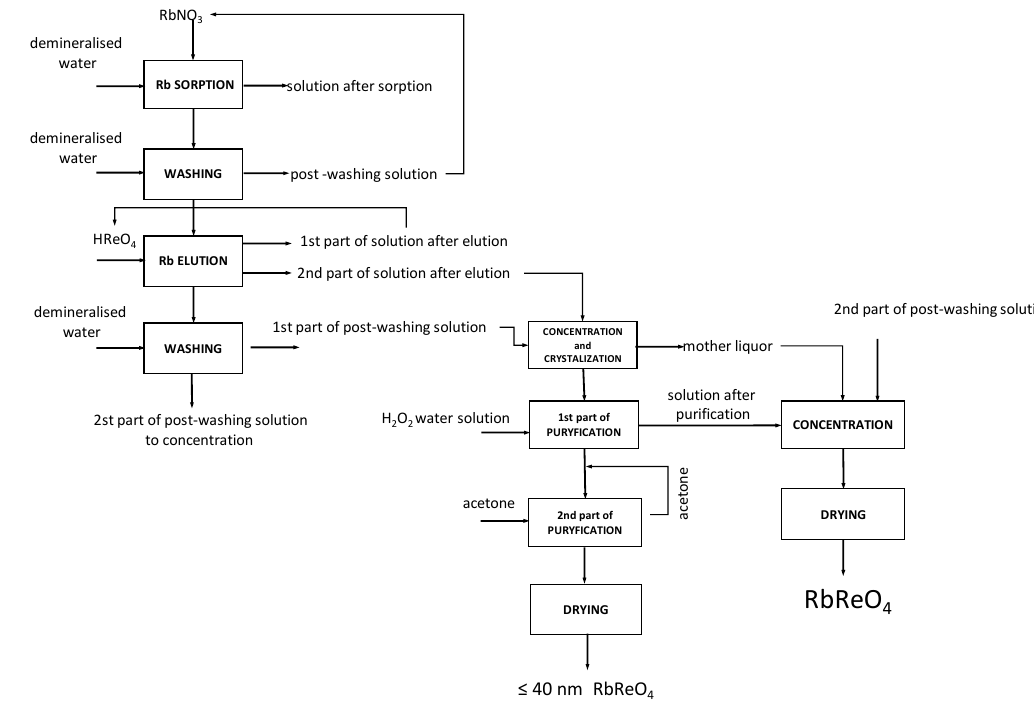
Figure 8. Technological scheme of anhydrous rubidium perrhenate preparation. The mass balances of rubidium and rhenium sorption and elution for the first and sixth cycles